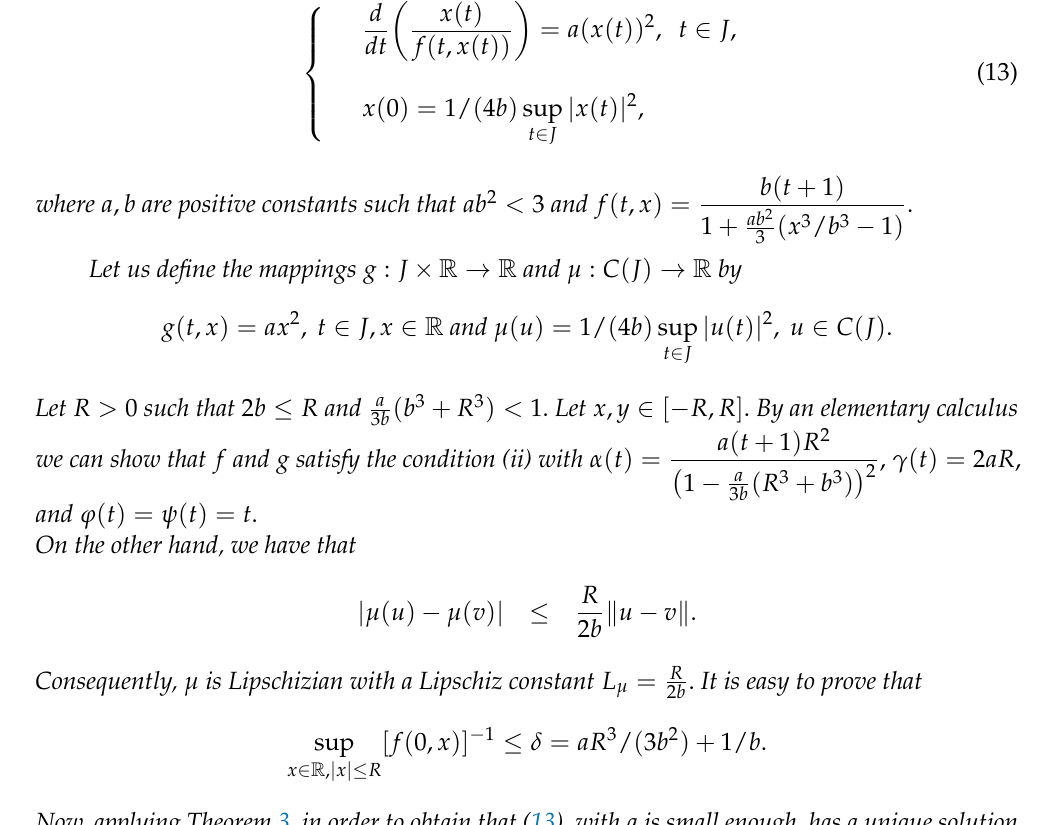
Table 2. Numerical results for (13) with initial x 0 ( t ) = 1